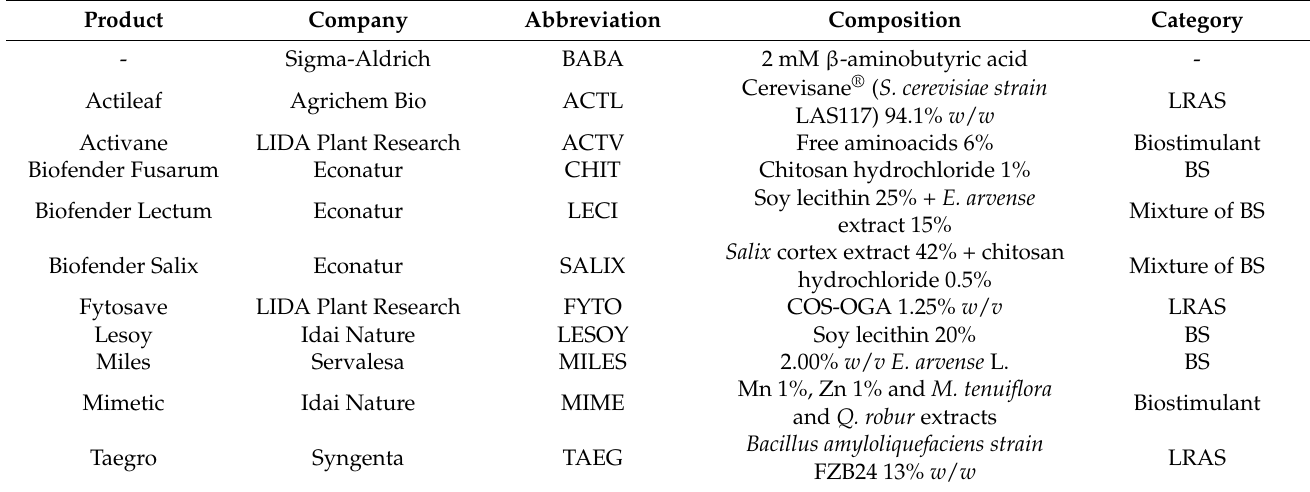
Table 1. List of the commercial products used in this study, including low-risk active substances (LRAS) and basic substances